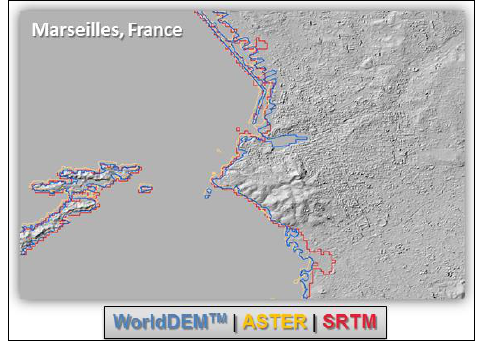
Figure 6. Analysis of shoreline in Marseilles, France based on different DEM